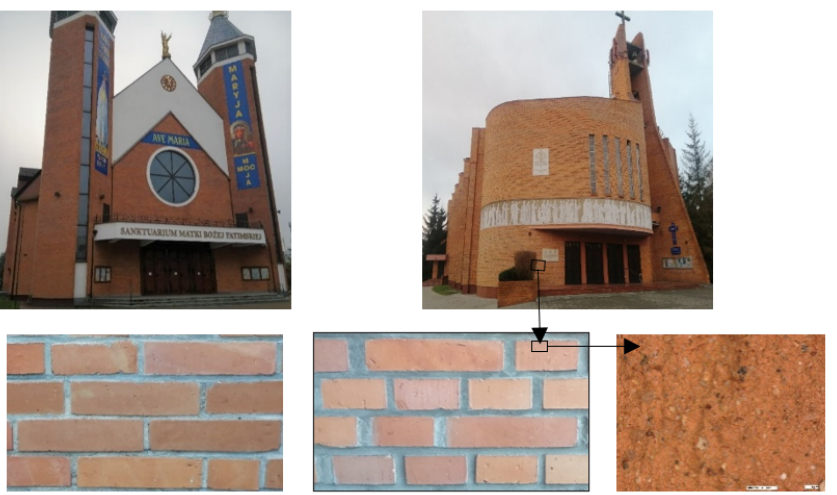
Figure 1. Religious buildings from the second half of the XX century with facing walls made